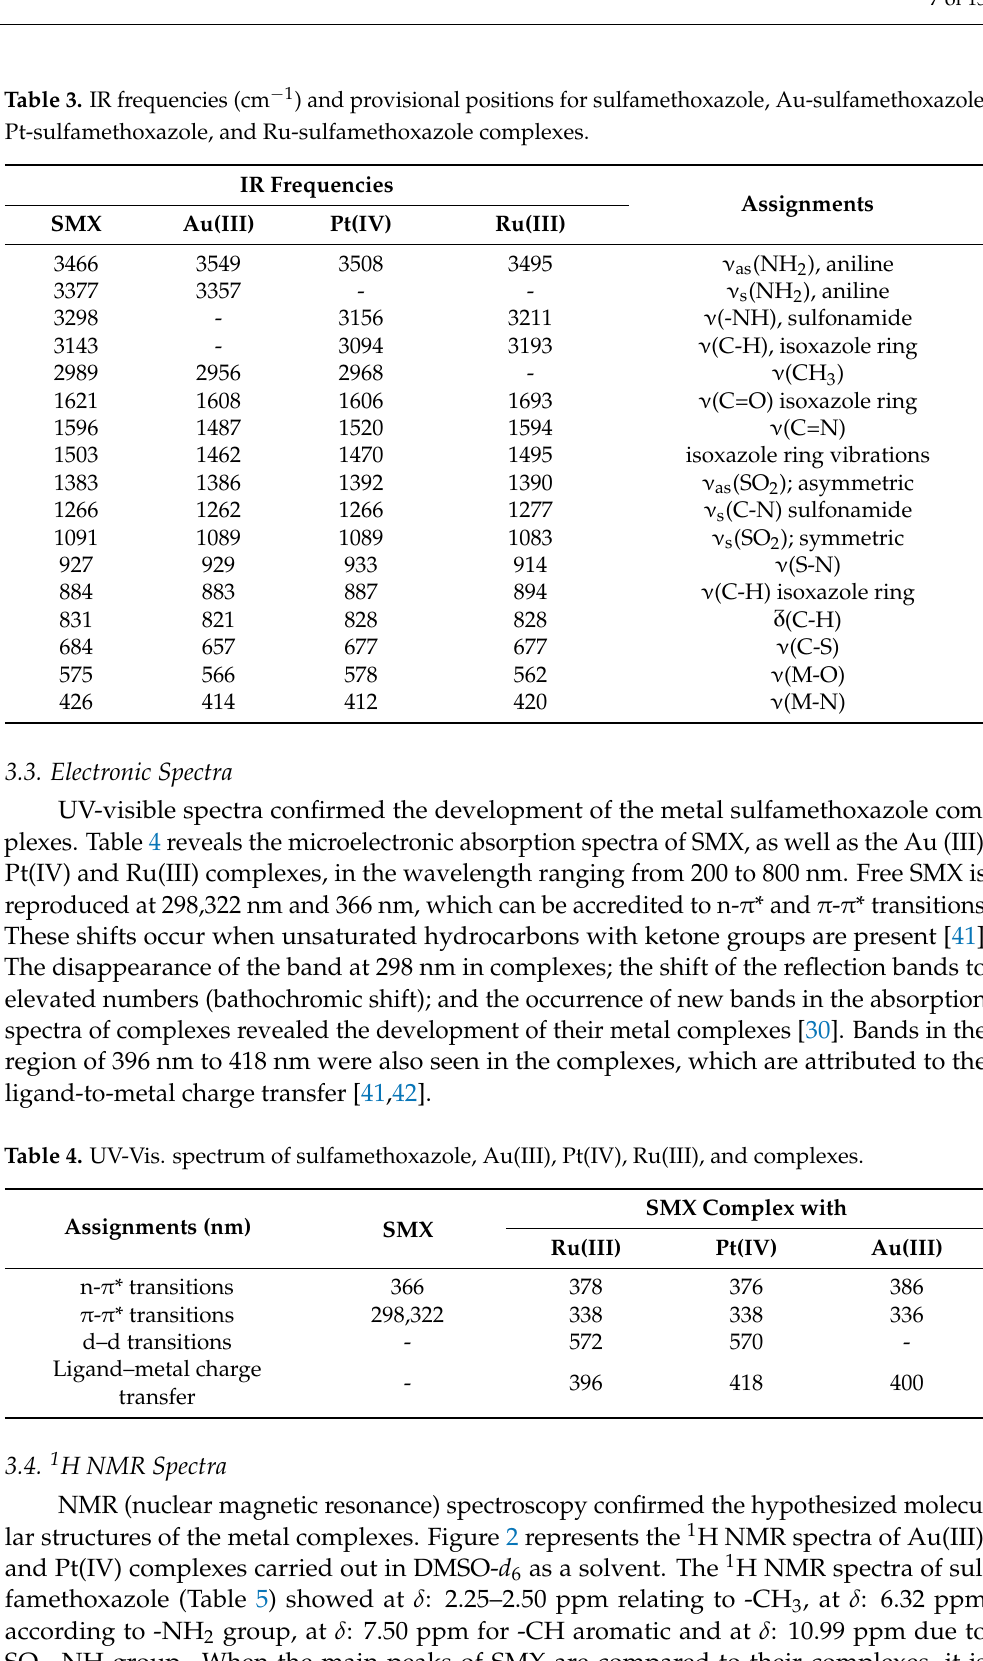
SMX Complex with Ru(III) Pt(IV) Au(III)